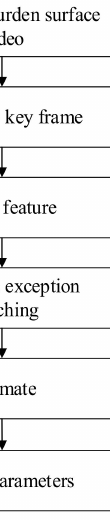
Figure 14. Overall block diagram of the virtual multi-head camera array